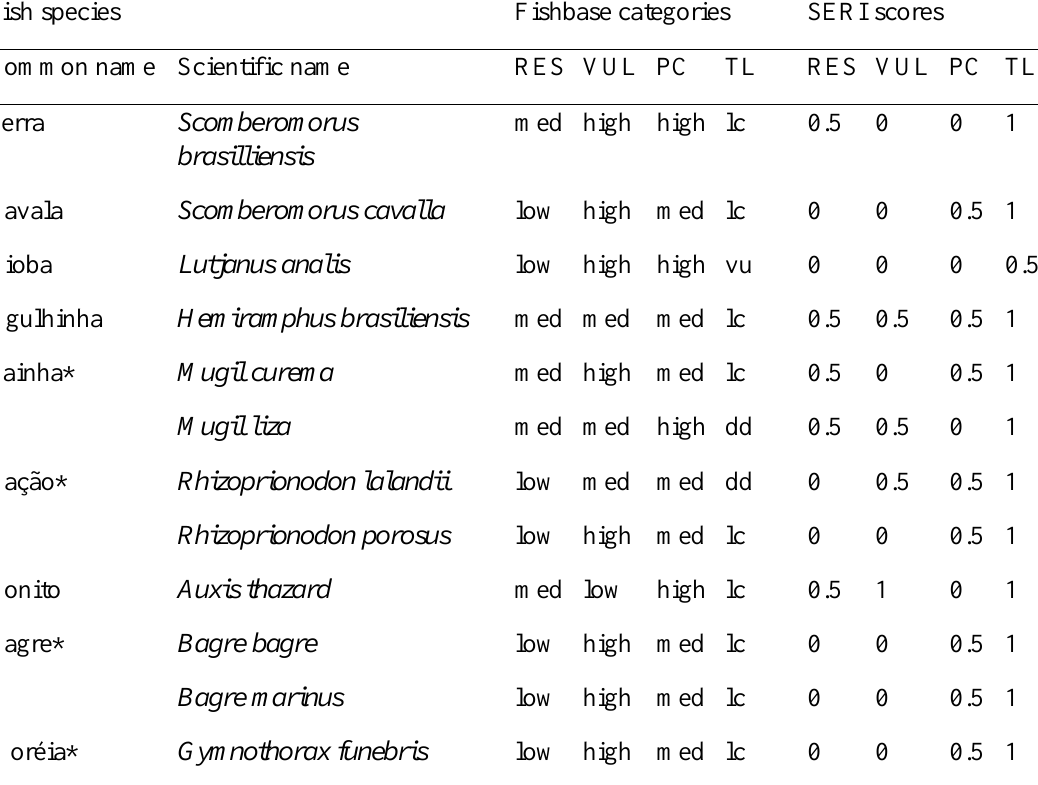
Table A4.1: List of fish species caught and cited by fishers during the interviews. The Fishbase categories were collected in Fishbase.org. The SERI scores were calculated following the instructions for Biological sensitivity in Section 2 of the manuscript. Some species were not identified (*) and an average value of species that occur in the region was used (using family, order and genus levels). SERI = Social-Ecological Resilience Index, RES = Resilience, VUL = Vulnerability, PC = Price category, TL = Threat level, med = medium, lc = least concern, vu = vulnerable, dd = data deficient, en = endangered, cr = critically endangered, nt = near